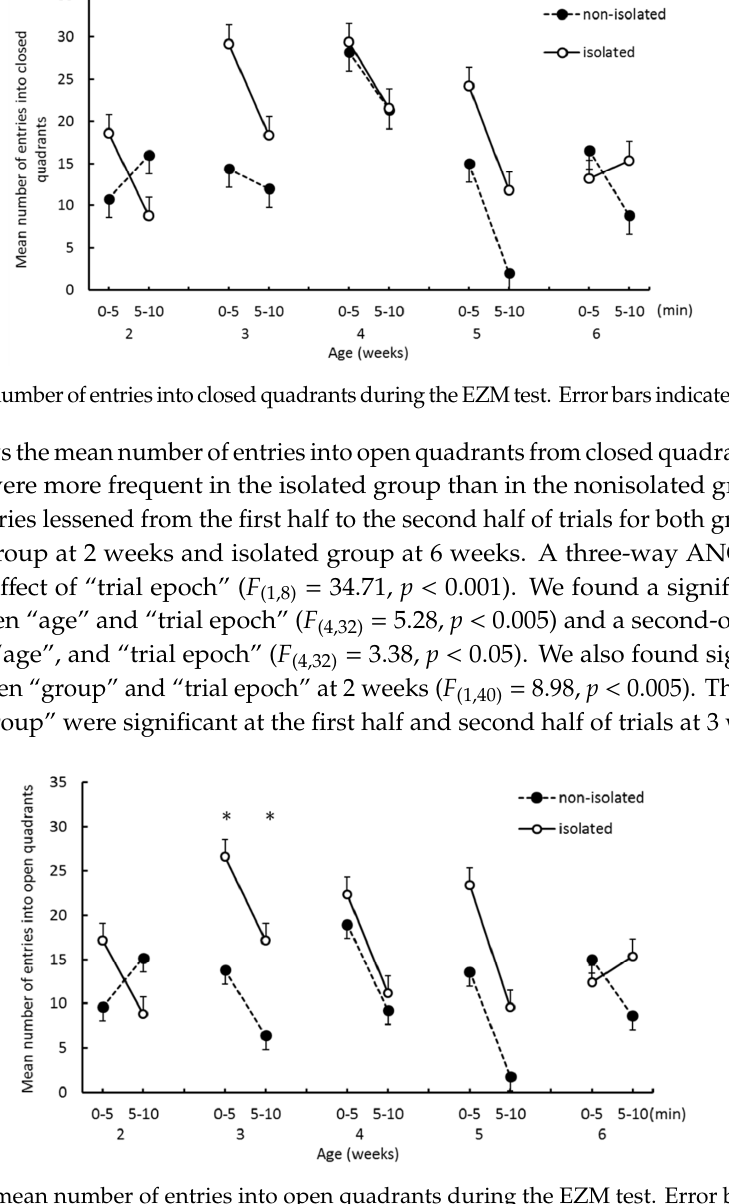
Figure 5. The mean number of entries into open quadrants during the EZM test. Error bars indicate the standard error. *significance at p <